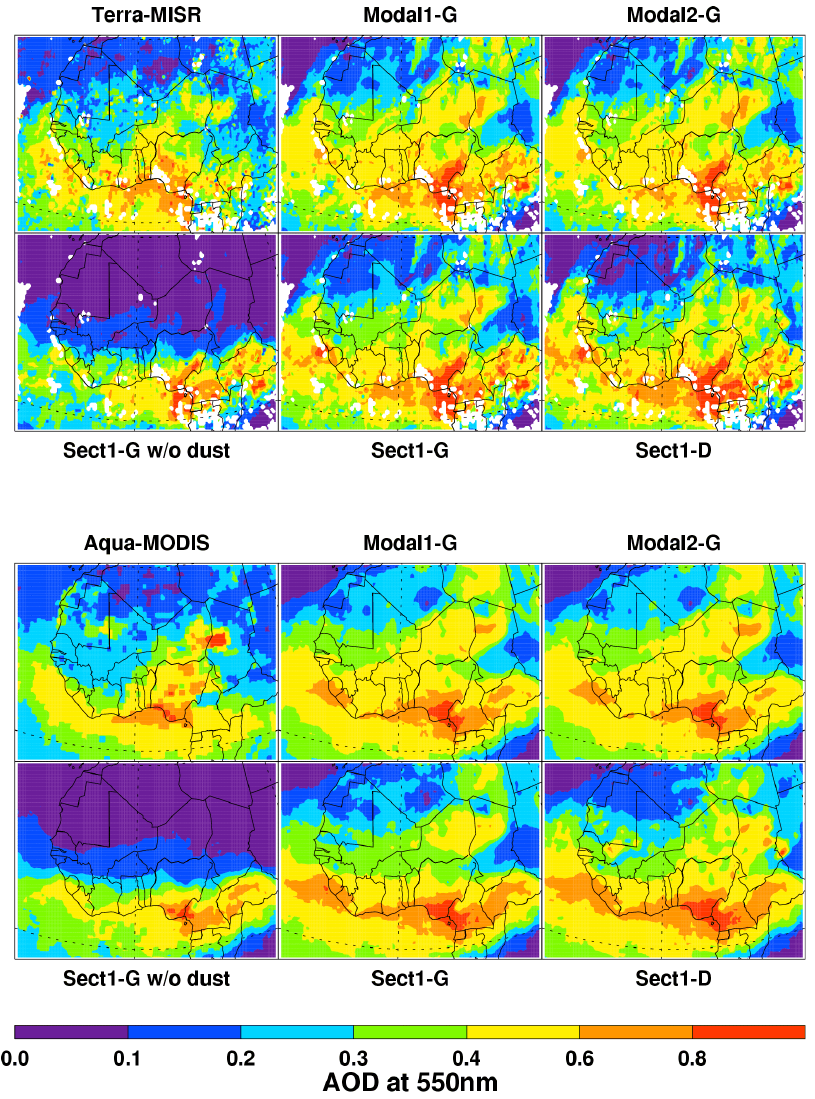
Figure 7 Averaged AOD at 550 nm over North Africa during the simulation period from the retrievals of MISR on Terra and MODIS on Aqua and the corresponding simulations of WRF-Chem in different cases. The MODIS retrievals are the combination of the standard (over ocean) and “Deep Blue” (over land) products. Model results are sampled at the time and locations of the MISR and MODIS retrievals respectively. The blank area in plots means no data available.